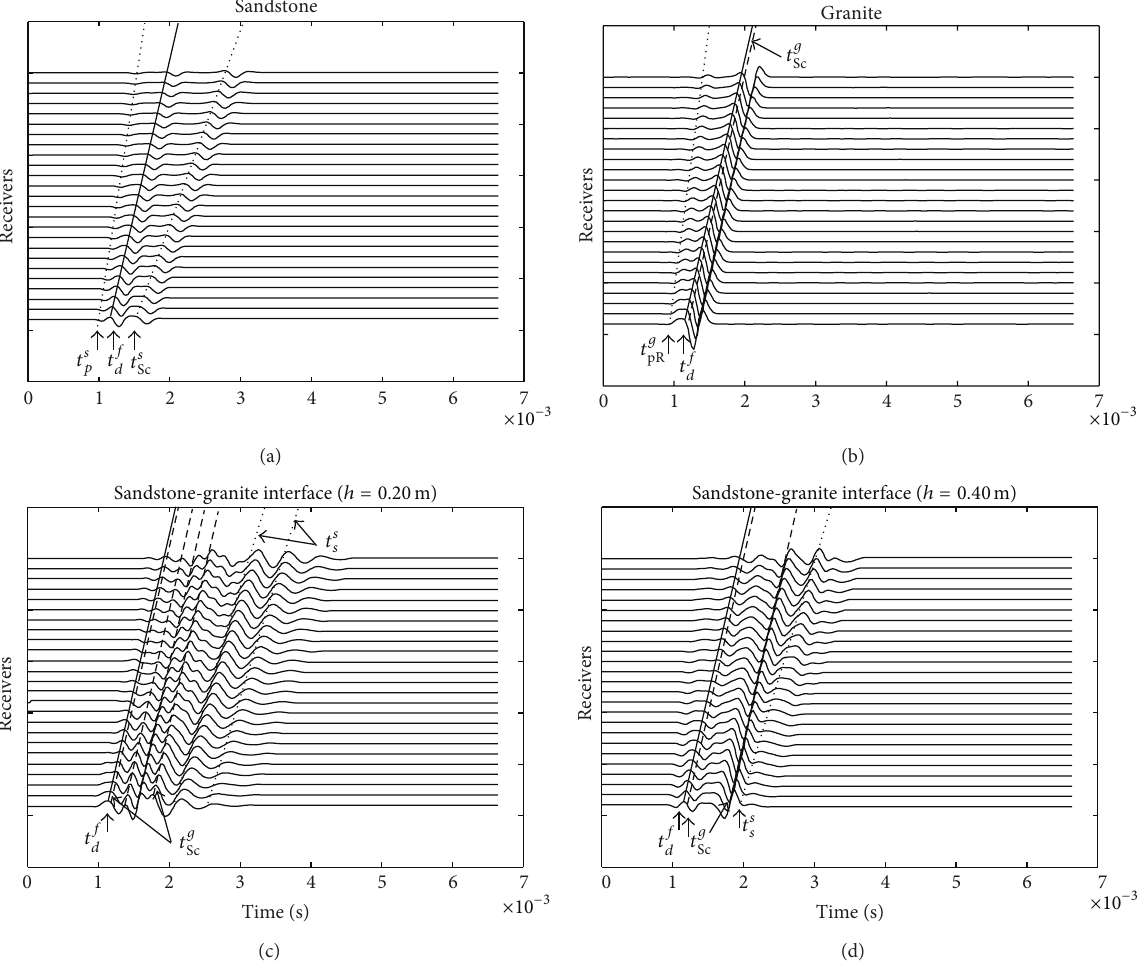
Figure 5: Synthetic seismograms of pressures by IBEM for cases 3 to 5 are shown. (a) Fluid-Sandstone interface, (b) fluid-granite interface, (c) fluid-sandstone-granite interface ( ℎ = 0.20 m), and (d) fluid-sandstone-granite interface ( ℎ = 0.40 m).